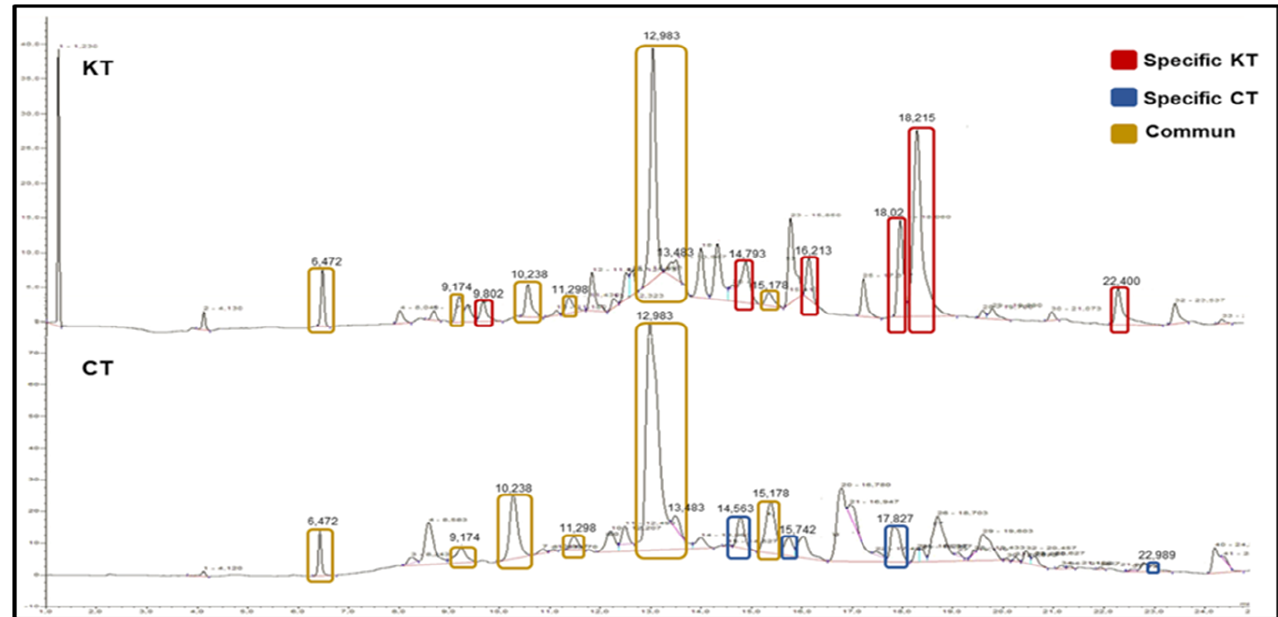
Figure 2. Representative fecal UHPLC spectra with retention time of samples from kidney transplant patients (KT) and healthy volunteers (CT). UHPLC analysis with C18 column, 30 °C, UV Diod Array detector from 190 nm to 1100 nm. The mobile phase used was HPLC water/Trifluoroacetic acid (0.08%) and Acetonitrile with a 95:5 gradient, flow rate of 1 mL/min. Yellow rectangles highlight common RPs between KT and CT groups. Red rectangles highlight specific RPs of the KT group. Blue rectangles highlight specific RPs of the control (T) group.